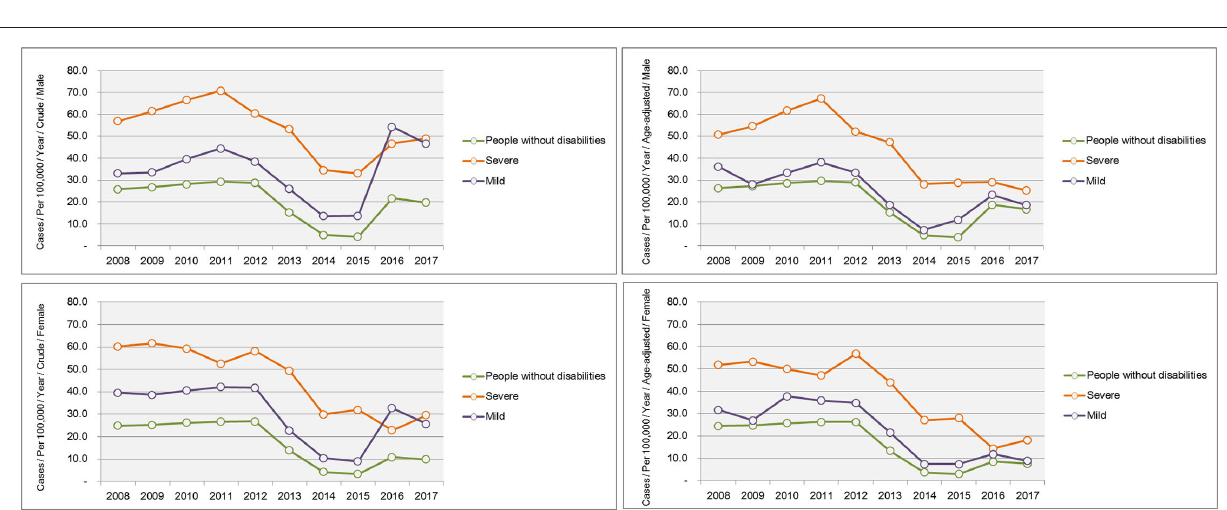
than non-disabled males and females in all years. The age-